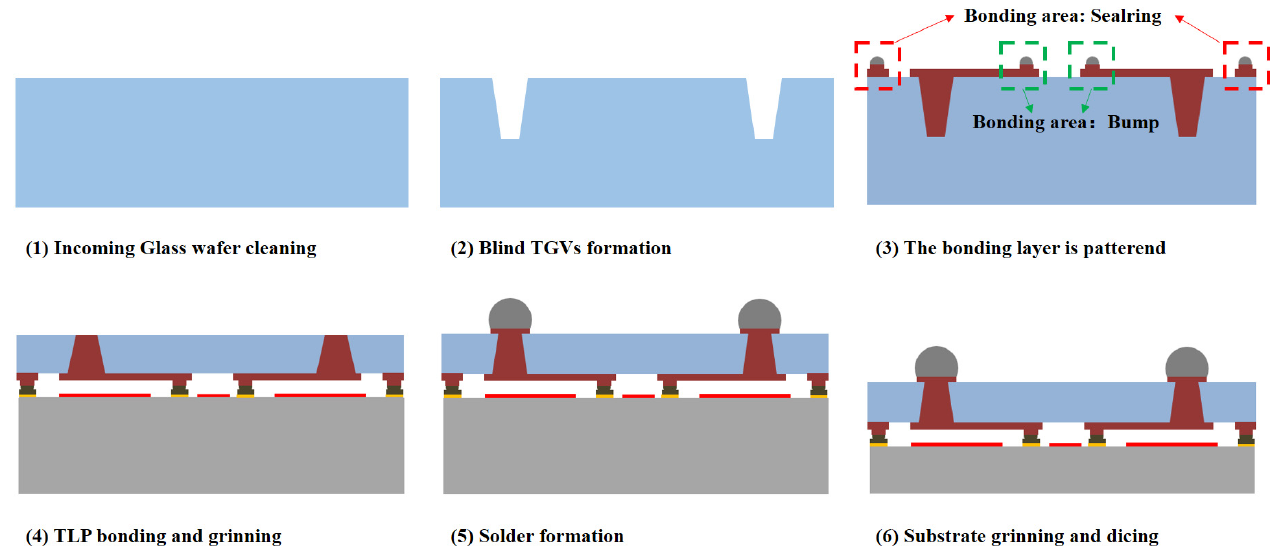
Figure 4. The process flow of the 3D WLP package.